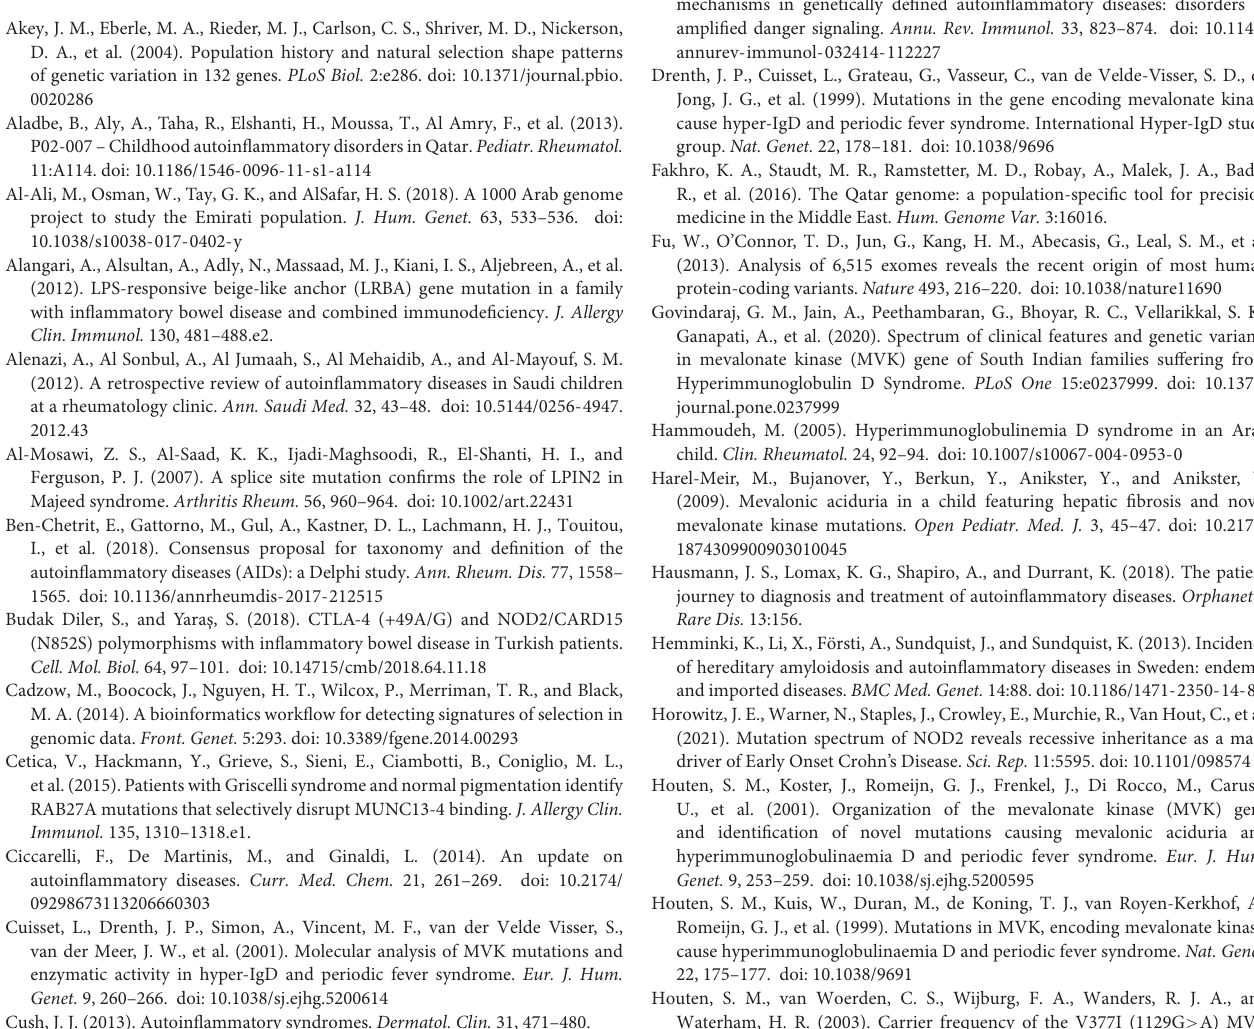
Supplementary Figure 1 | Schematic summarizing the data analysis pipeline utilized for this study. Supplementary Table 1 | Genes and associated autoinflammatory diseases considered in the present analysis and their respective inheritance patterns.